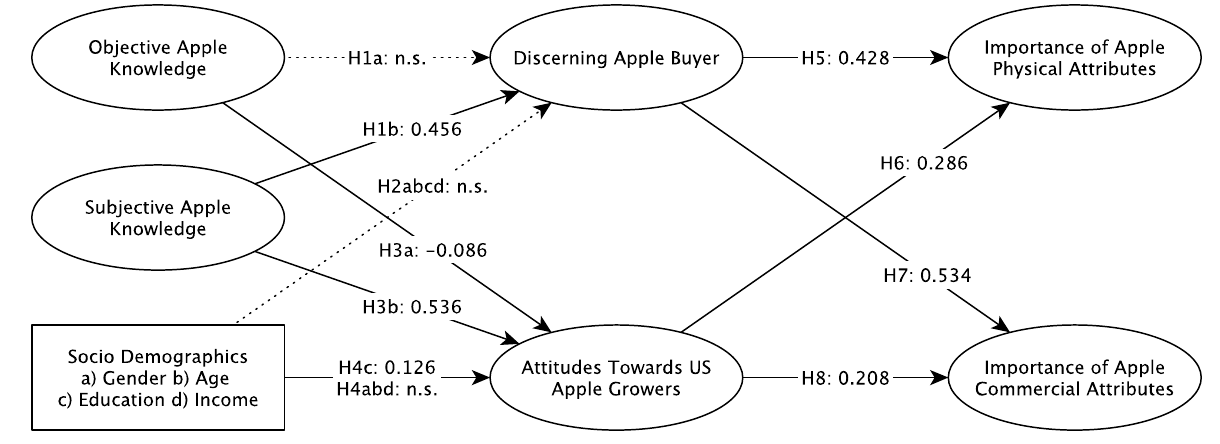
Figure 2. Results of the conceptual model .